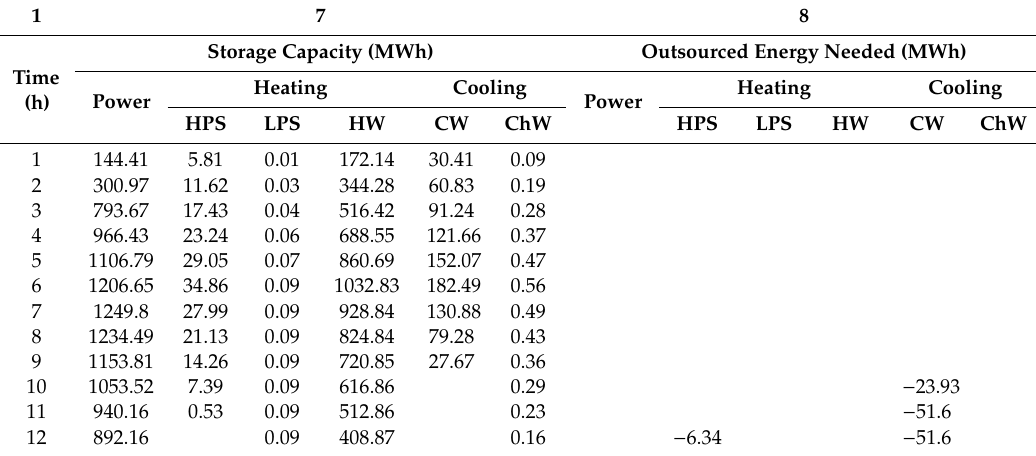
Table A17. TriGenSCT of final trigeneration PWR NPP with integration from time 1 to 12 h.